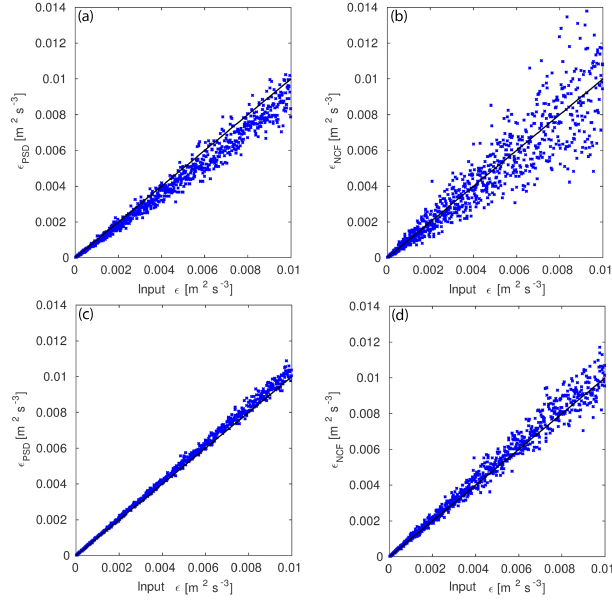
Figure 8. Estimated values of (cid:15) PSD and (cid:15) NCF for synthetic 40Hz signals and fitting range 0.3–5Hz as functions of the correspond- ing input (cid:15) resulting from the theoretical profile, Eq. (29), for (a) and (b) signals with L ≈ 50 L 0 and for (c) and (d) signals with L ≈ 400 L 0